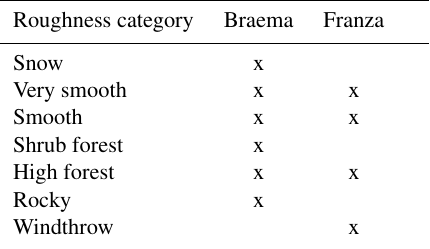
Table 2. Roughness categories using orthophotos and the vegetation height model (VHM) were selected to evaluate the different surface roughness